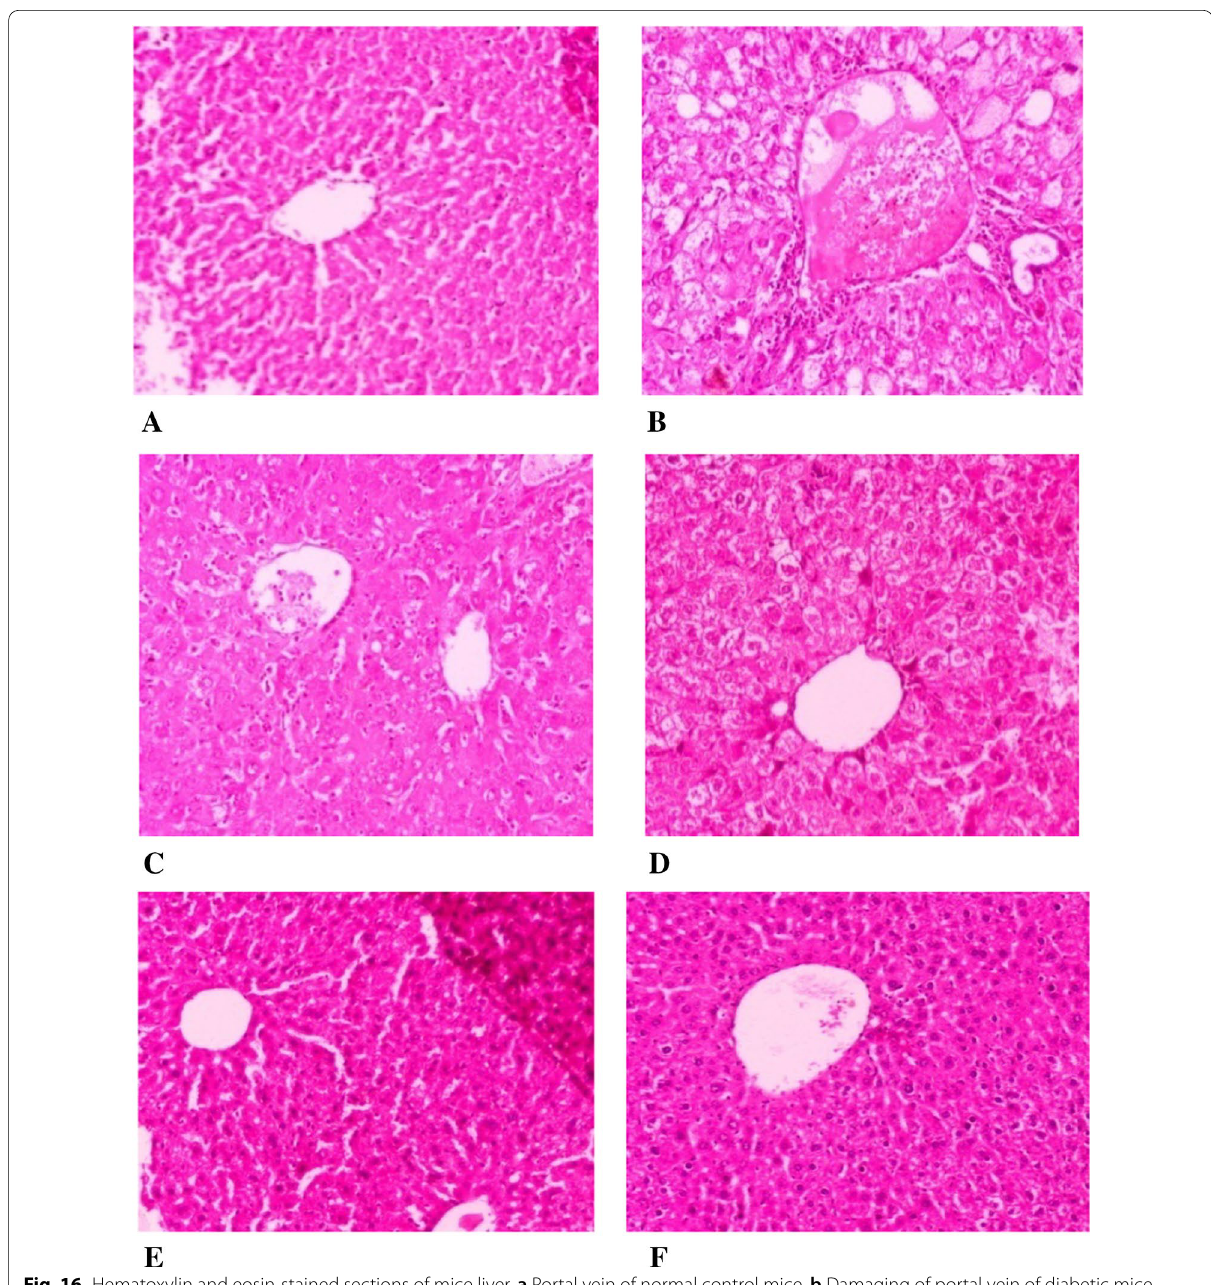
Fig. 16 Hematoxylin and eosin-stained sections of mice liver. a Portal vein of normal control mice. b Damaging of portal vein of diabetic mice ( c – e ) portal vein of diabetic mice treated with c 100 mg/kg and d 200 mg/kg e 300 mg/kg per day MELCF which reduced the development of STZ-induced alterations in the liver. f Portal vein of metformin 200 mg/kg treated